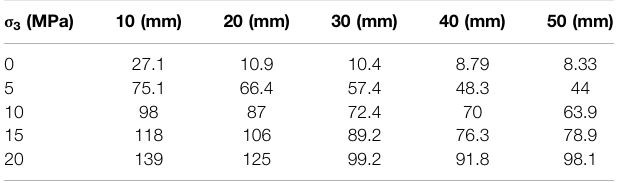
TABLE 6 | Elastic Modulus (GPa) of the RCR composites at different inclined coal seam thicknesses and different con fi ning